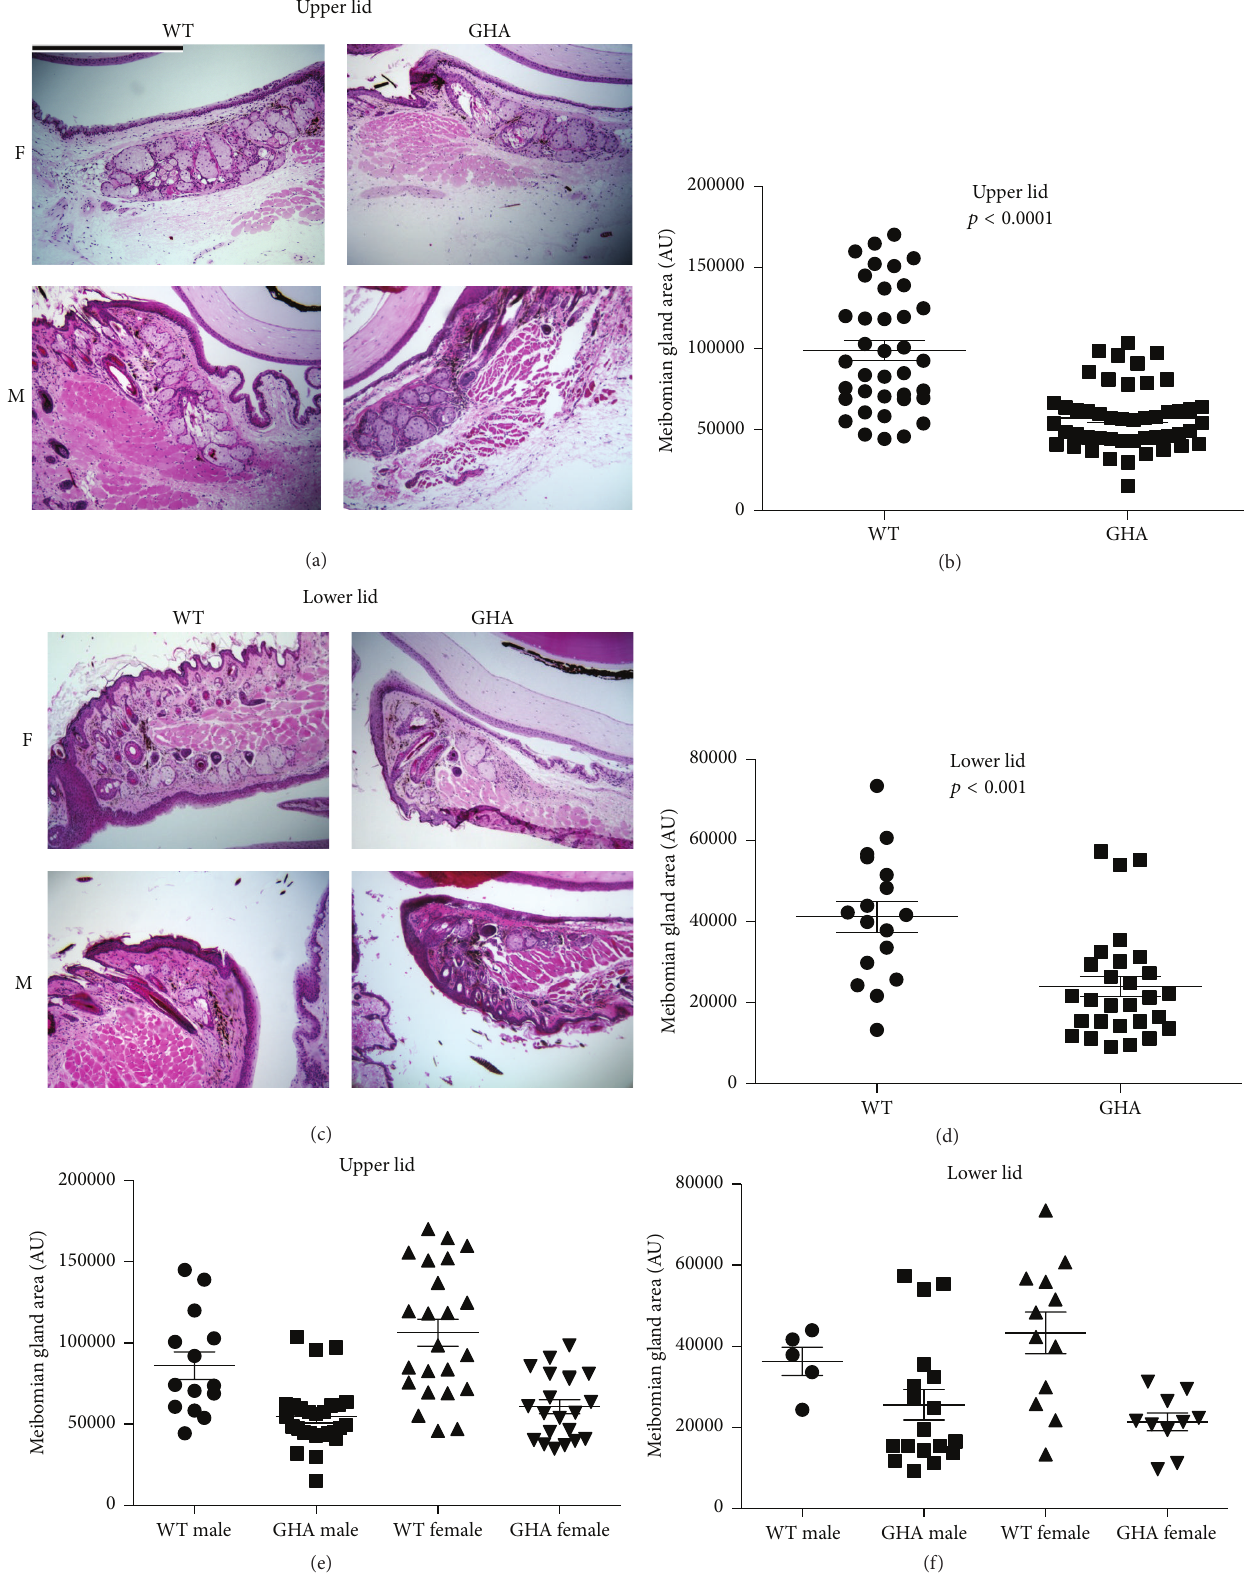
Figure 4: Meibomian gland morphology and size (i.e., area measurement) in both male and female GHA and WT control mice. (a) and (c) H & E staining in the upper and lower lid tissue showing meibomian glands. (b) and (d) quantification of upper and lower lid meibomian gland size without distinguishing sexes. (e) and (f) quantification of upper and lower lid meibomian gland size of both sexes. Each data point represents the size of one meibomian gland, the horizontal bar represents the mean, and the error bar represents SEM. Data were pooled from 𝑁 = 5 mice in each group. The magnifications for all photographs are 100x, and the size bar in (a) is 500 𝜇 m in